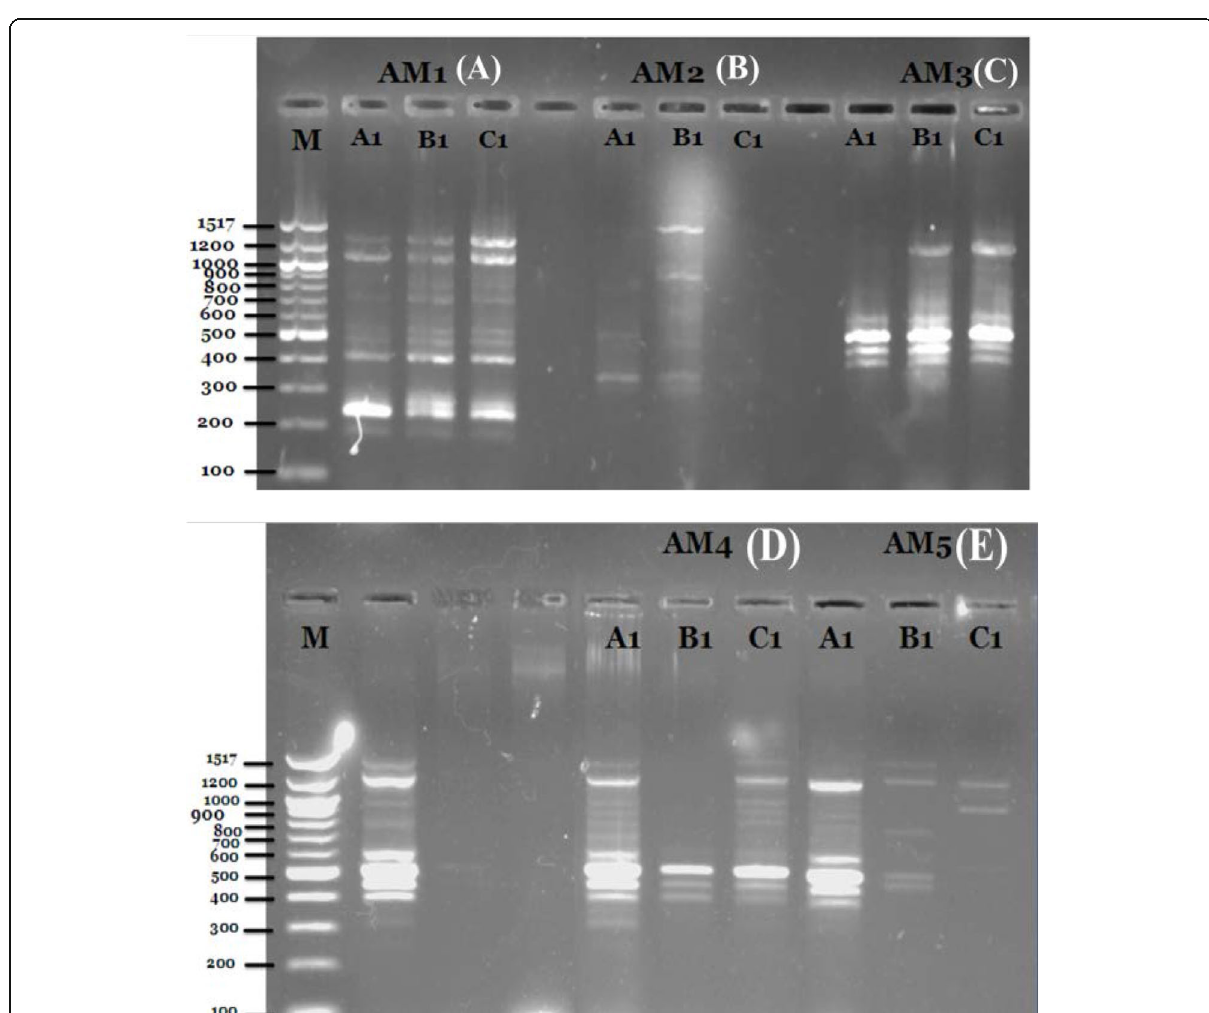
Fig. 5 Agarose gel electrophoresis of inter simple sequence repeat (ISSR) fragments. Lane 1 (A1) refers to mother plants, lane 2 (B1) refers to in vitro propagated plants, lane 3 (C1) refers to plants regenerated from callus, and lane M indicates molecular weight DNA ladder given in bp (100 – 1517). Polymorphic DNA fragments are identified by an